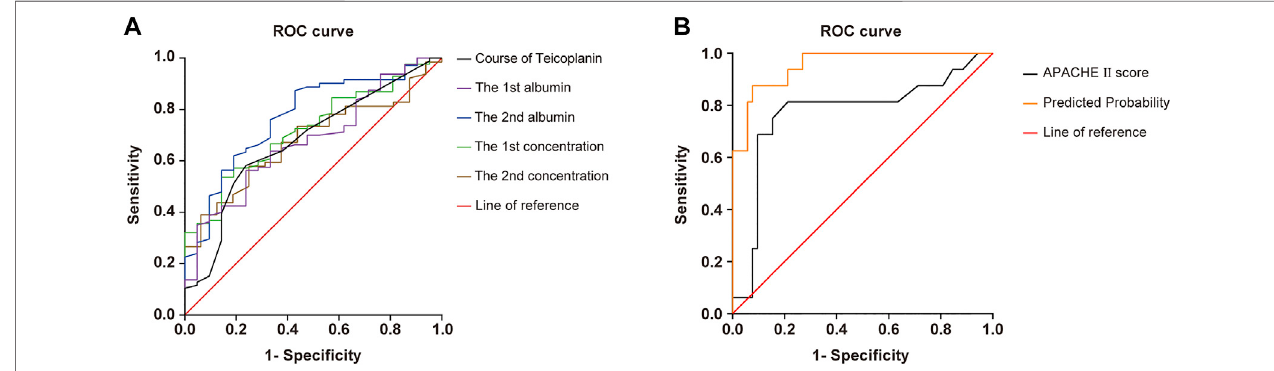
FIGURE2| ROCcurveofpredicted probability,APACHE Ⅱ scoreatadmission,courseofTEI,the1stalbumin,the2ndalbumin,the1stconcentration,andthe2nd concentration, which were independent risk factors, and combined predictor on clearance of Gram-positive bacteria. The predicted probability of the APACHE Ⅱ score (AUC = 0.772), the course of TEI (AUC = 0.646), the 1st albumin (AUC = 0.758), the 2nd albumin (AUC = 0.764), the 1st concentration (AUC = 0.710), and the 2nd concentration (AUC = 0.666) had better sensitivity (87.5%) and speci fi city (92.3%), Youden index of 0.798, as well as the maximal AUC (AUC = 0.954).